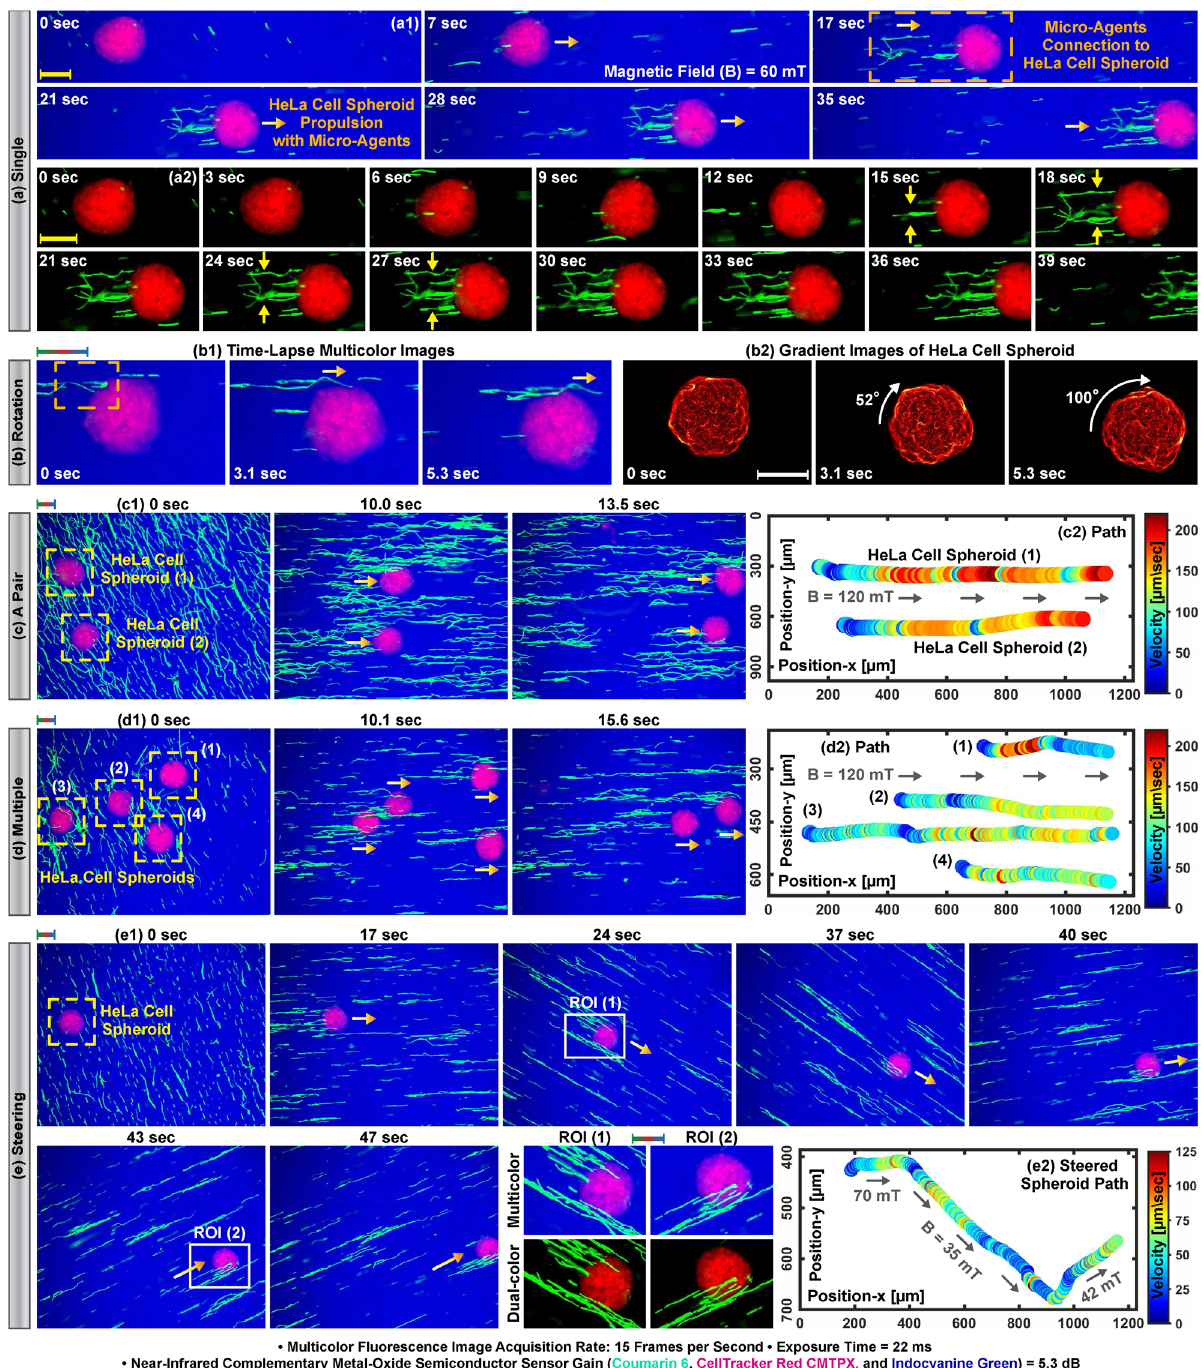
Figure 4. Translation of HeLa cell spheroids by magnetic micro-agents in a reservoir filled with culturing medium and indocyanine green. ( a1 ) Propelling a single spheroid by micro-agents connection. ( a2 ) Time-lapse dual-color microscopy for connection of micro-agents to the spheroid. ( b1 ) Rotation of a spheroid caused by micro-agents propelling. ( b2 ) Demonstration of the spheroid rotation by gradient images. ( c1 , d1 ) Simultaneous translation of two and multiple spheroids by micro-agents, respectively. ( e1 ) Steering a spheroid propelled with micro-agents by changing the magnetic field direction. ( c2 – e2 ) Path and velocity information of the spheroids in ( c1 – e1 ), respectively. Scale bar 100 µ m. Please refer to the accompanying video (Part